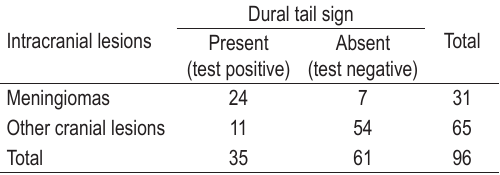
TABLE 2. Presence of the dural tail sign in meningiomas and other cranial lesions (Data for diagnostic test analysis 2 by